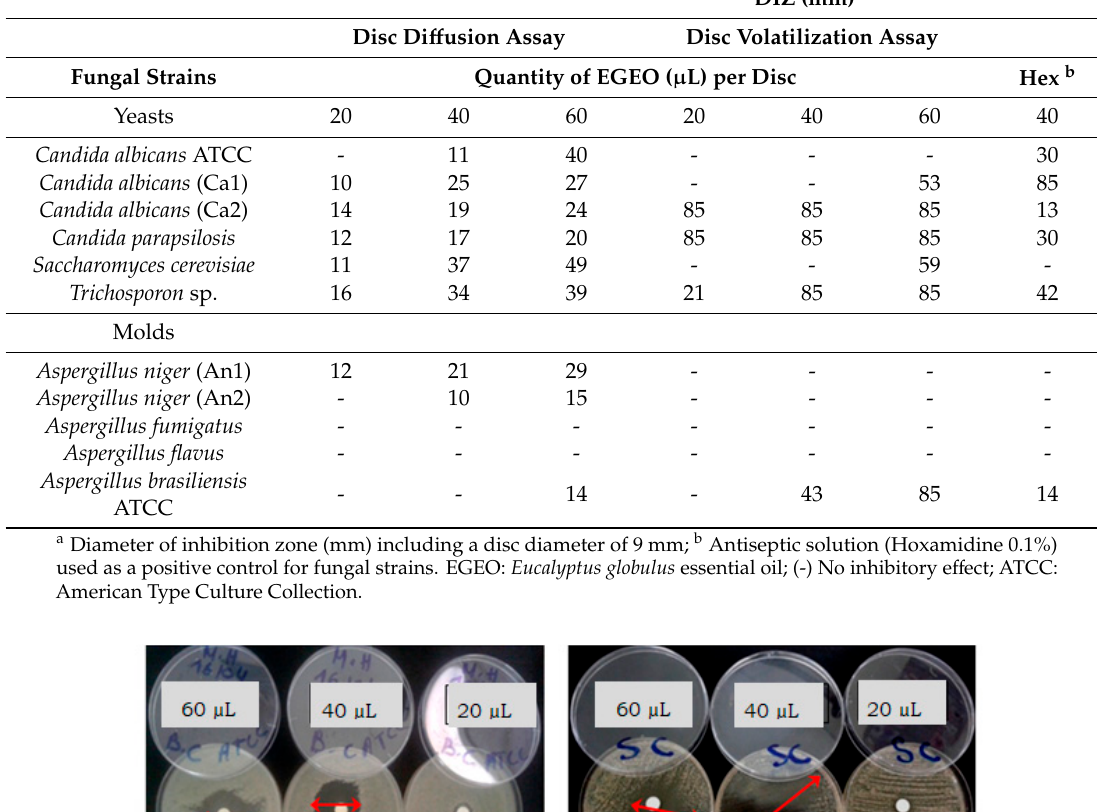
(Hoxamidine 0.1%) used as a positive control for fungal strains. EGEO: Eucalyptus globulus essential oil; (-) No inhibitory effect; ATCC: American Type Culture Collection.